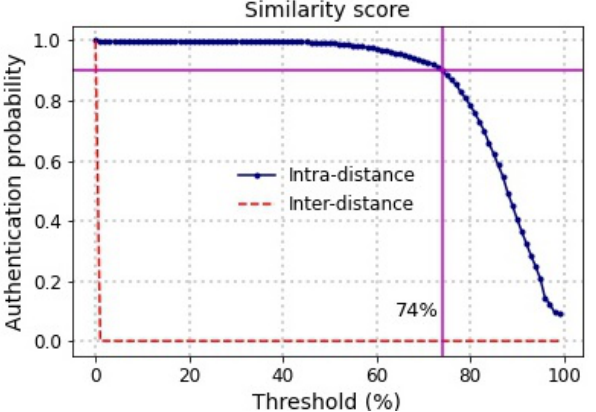
Figure 8. True/False-positive acceptance rate at changing of the similarity score used as a threshold. Setting the threshold at 74% gives a true acceptance rate of about